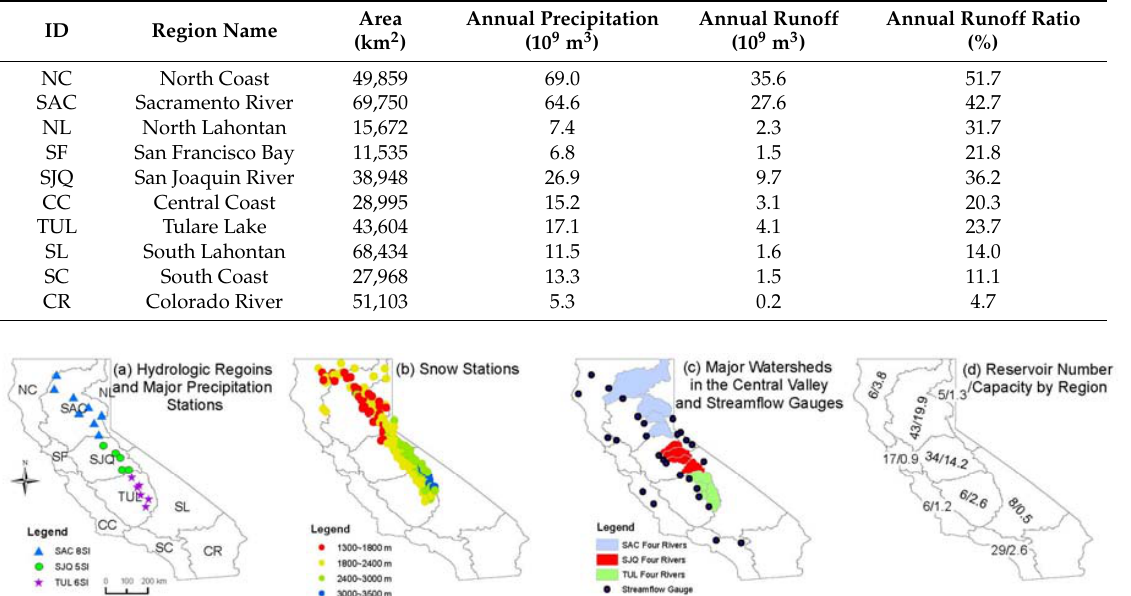
Table 1. General geographic and hydrologic characteristics of the 10 hydrologic regions.